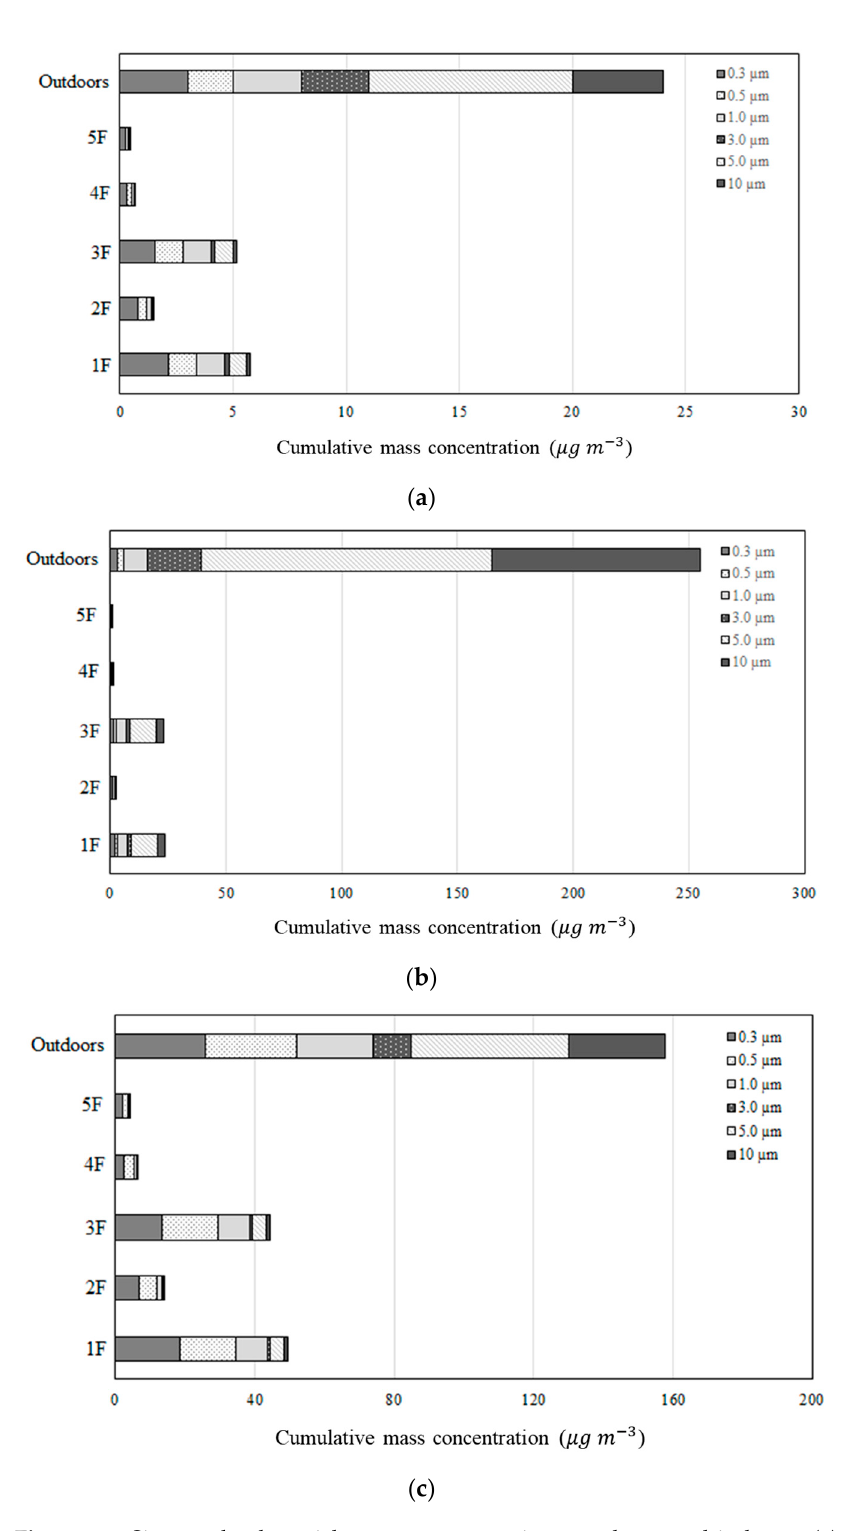
Figure 11. Size-resolved particle mass concentrations outdoors and indoors: ( a ) normal period, ( b ) yellow-dust period, ( c ) smog